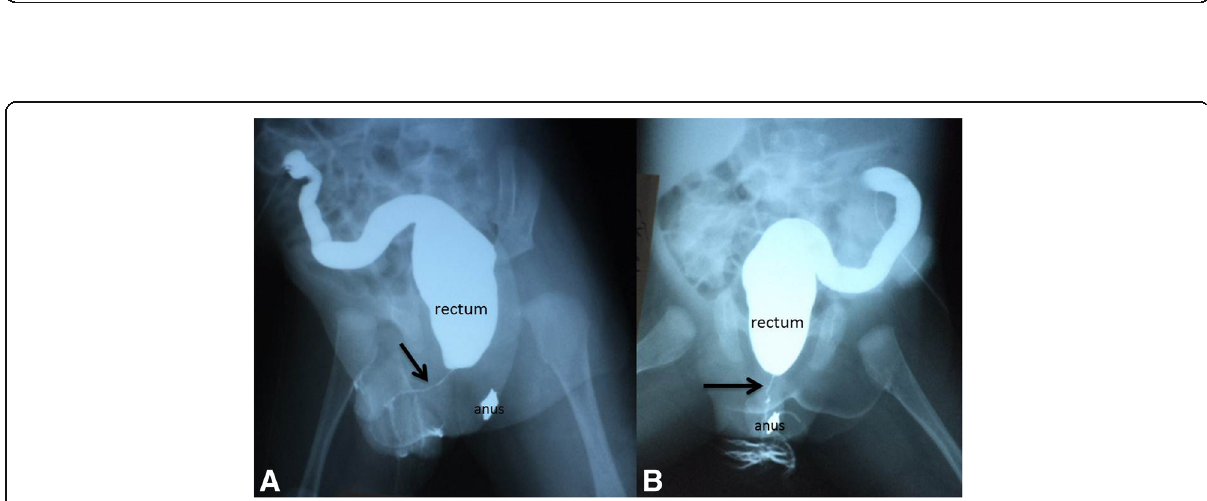
Fig. 14 Recto-vaginal fistula in an infant. a , b Ascending and voiding cysto-urethrogram images showing the fistulous tract (arrows) between the rectum and the vagina